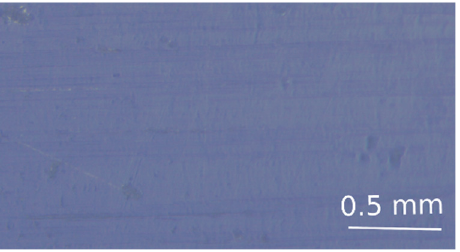
Table 1. Composition of AA6060 alloy employed (wt.%).